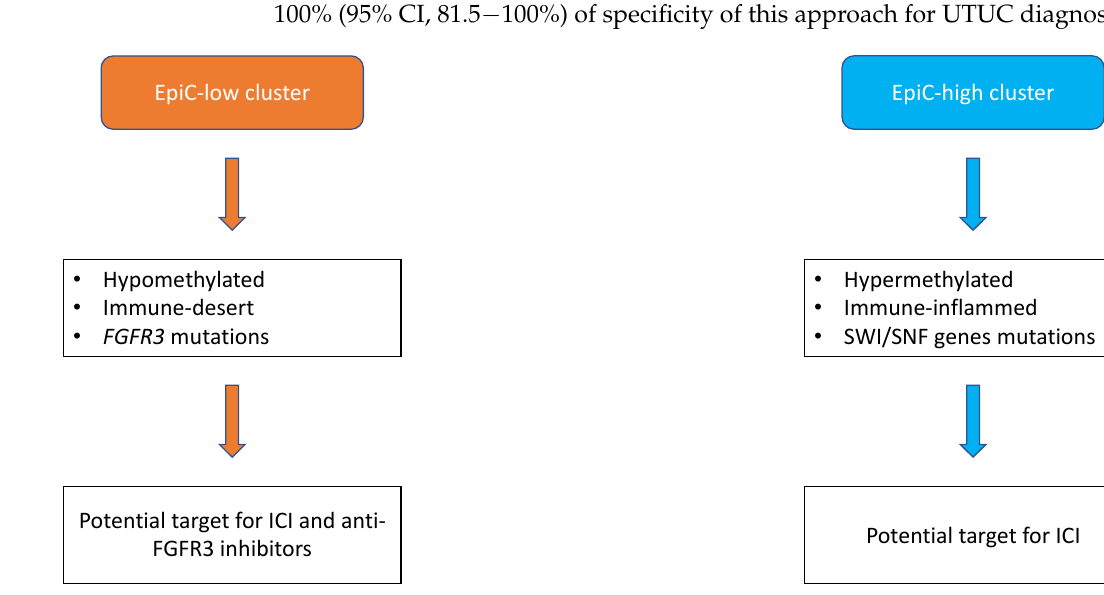
Figure 1. Proposal of molecular subtypes classification of upper-tract urothelial carcinomas adapted from Su et al. [12]. Broadly, upper-tract urothelial carcinomas can be divided into two subtypes, namely EpiC-high and EpiC-low. Epic-low subtype is hypomethylated, immune-desert, and characterized by FGFR3 somatic mutations with potential efficacy of the combination of FGFR3 immunotherapy and immune checkpoint inhibitors (ICI). Conversely, EpiC-high subtype is hypermethylated, immune-inflamed, and enriched with somatic mutations of SWI/SNF genes with potential benefit for ICI.